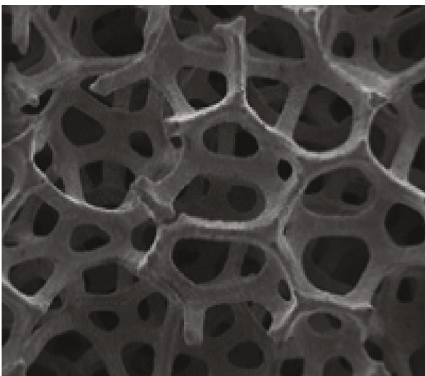
Figure 1: Microscopic geometry of foamed copper under electron